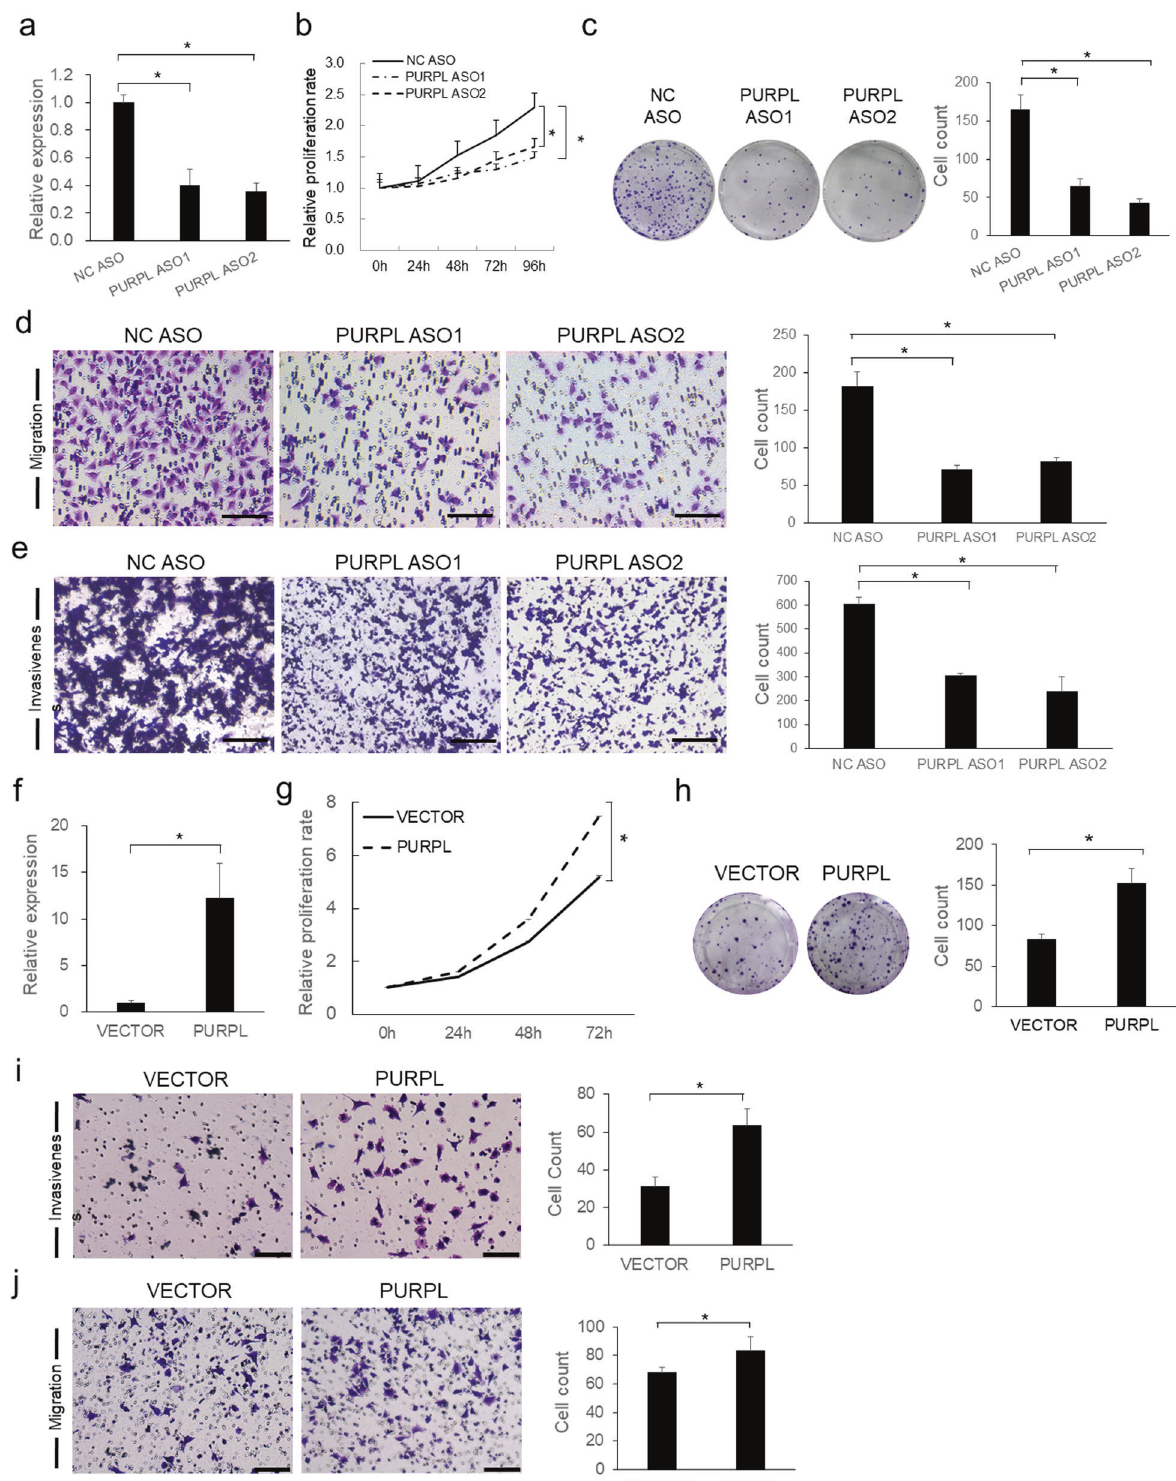
Fig. 2 PURPL promotes cell proliferation, migration, and invasiveness in melanoma cells. a PURPL RNA expression was detected by qPCR after depletion of PURPL by ASOs in A375 cells. Measurement of cell proliferation by CCK-8 assay ( b ), colony formation assay ( c ), transwell migration assay ( d ), and matrigel invasiveness measurement ( e ) were performed in A375 cells treated with ASOs targeting PURPL. f PURPL RNA expression was detected by qPCR after overexpression of PURPL in A375 cells. Measurements of cell proliferation by CCK-8 assay ( g ), colony formation assay ( h ), transwell migration assay ( i ), and matrigel invasiveness measurement ( j ) were performed in A375 cells overexpressing PURPL. Scale bar: 100 µm. One-way ANOVA and Dunnett ’ s multiple comparison test. Means ± s.d. * P < 0.05, ** P < 0.01, *** P <